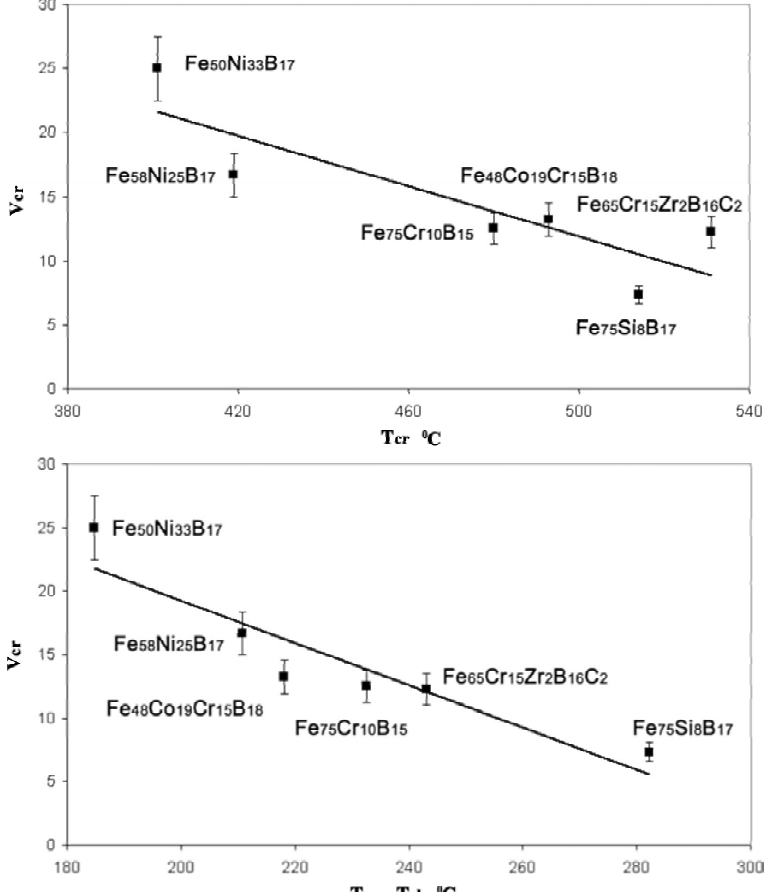
Fig. 9. Correlation between the values of V and T and taking into account (b) different dissipative capacity of the shear bands; correlation coefficient r = 0.74 (a) and r = 0.86